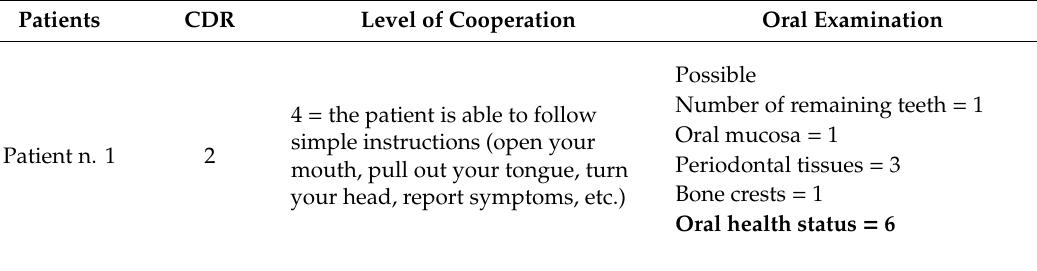
Table 2. CDR, Level of Cooperation, Oral Health